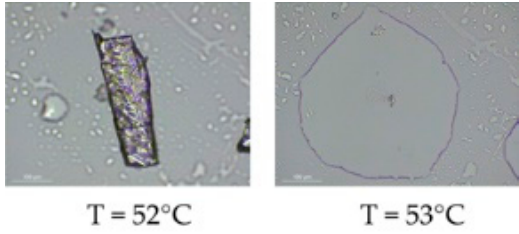
Figure 2. Hot stage microscopy images collected at 52 and 53 °C of a crystal of BE_IV.